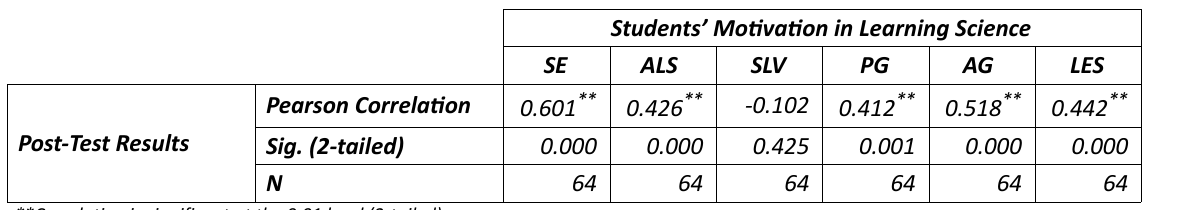
Table 4. The Relatonship of the Students’ Motvaton in Learning Science to their Academic Performance Table 4 presents the relatonship of the students’ motvaton in learning Science and their